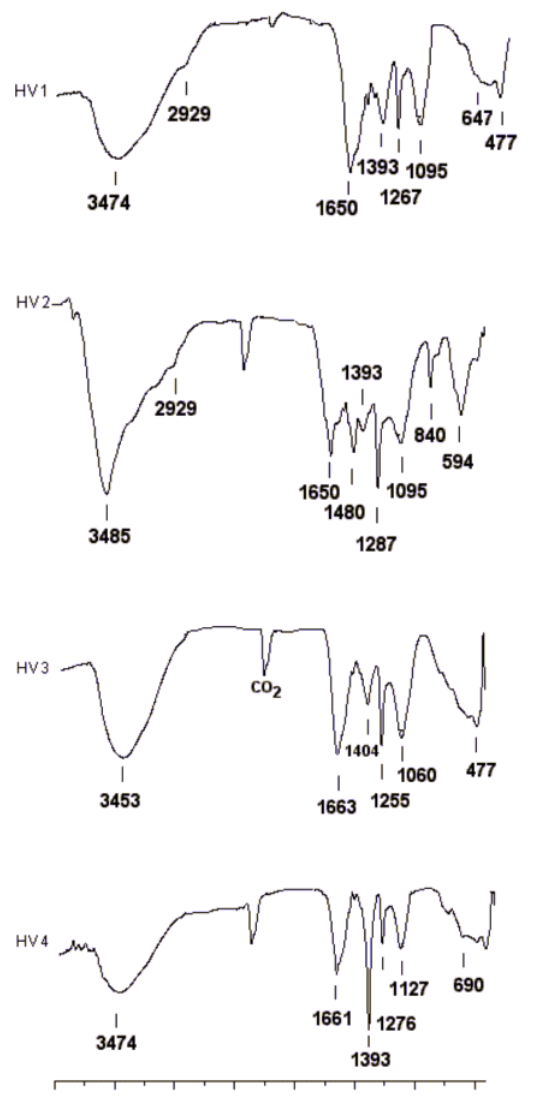
Figura 1. Espectros na região de infravermelho com transformada de Fourier (em cm -1 ) dos humatos extraídos de vermicomposto de esterco de curral (HV1), de esterco de curral + bagaço de cana-de-açúcar (HV2), de esterco de curral + folhas de leguminosas (HV3) e de esterco de curral + bagaço de cana-de-açúcar + folhas de leguminosas (HV4)